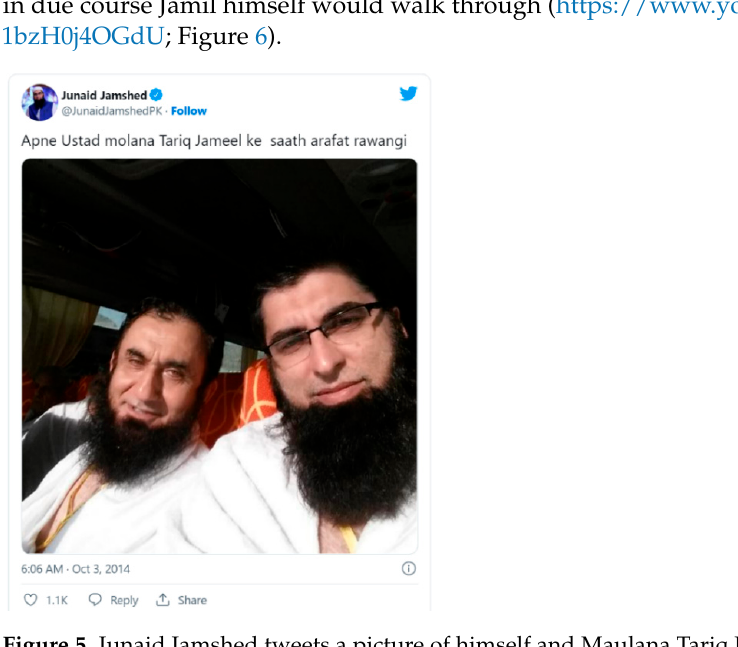
Figure 5. Junaid Jamshed tweets a picture of himself and Maulana Tariq Jamil in pilgrim garbs en route to Arafat as part of the 2014 Hajj pilgrimage. Source: https://twitter.com/junaidjamshedpk/sta-